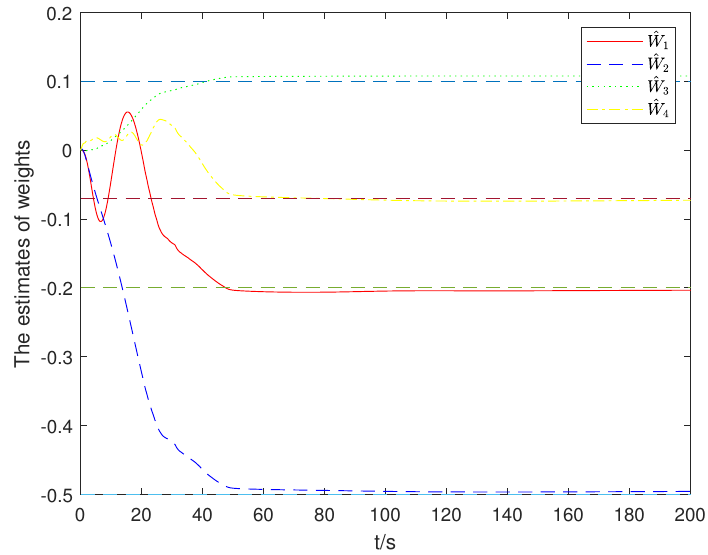
Figure 4. The NN weight estimations and set